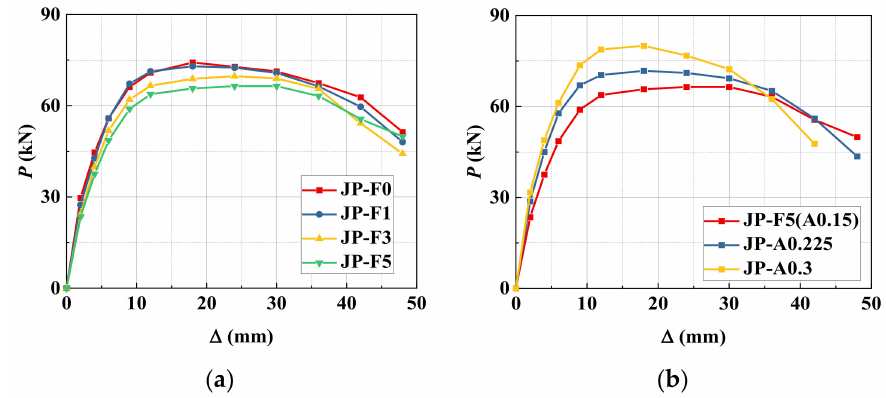
(2) Under the same 125 seawater freeze–thaw cycles, the influences of different axial compression ratios, longitudinal reinforcement diameters, and stirrup spacings on the skele- ton curve of specimens were compared, as shown in Figure 31b–d. The axial compression ratio of the low cyclic loading test increased from 0.15 to 0.3, and the shape of the skeleton curve changed from relatively “flat” to “steep”; that is, the initial stiffness of the skeleton curve increased, as shown in Figure 31b. The peak load increased by 15%, while the peak displacement decreased by 40%. As the longitudinal reinforcement diameter of specimens increased from 12 mm to 16 mm, the shape of the skeleton curve remained unchanged, as shown in Figure 31c, and the peak load and displacement increased by 27% and 20%, respectively. As the stirrup spacing of specimens decreased from 100 mm to 50 mm, the peak load remained unchanged, as shown in Figure 31d, and the ductility coefficient of the specimens increased by